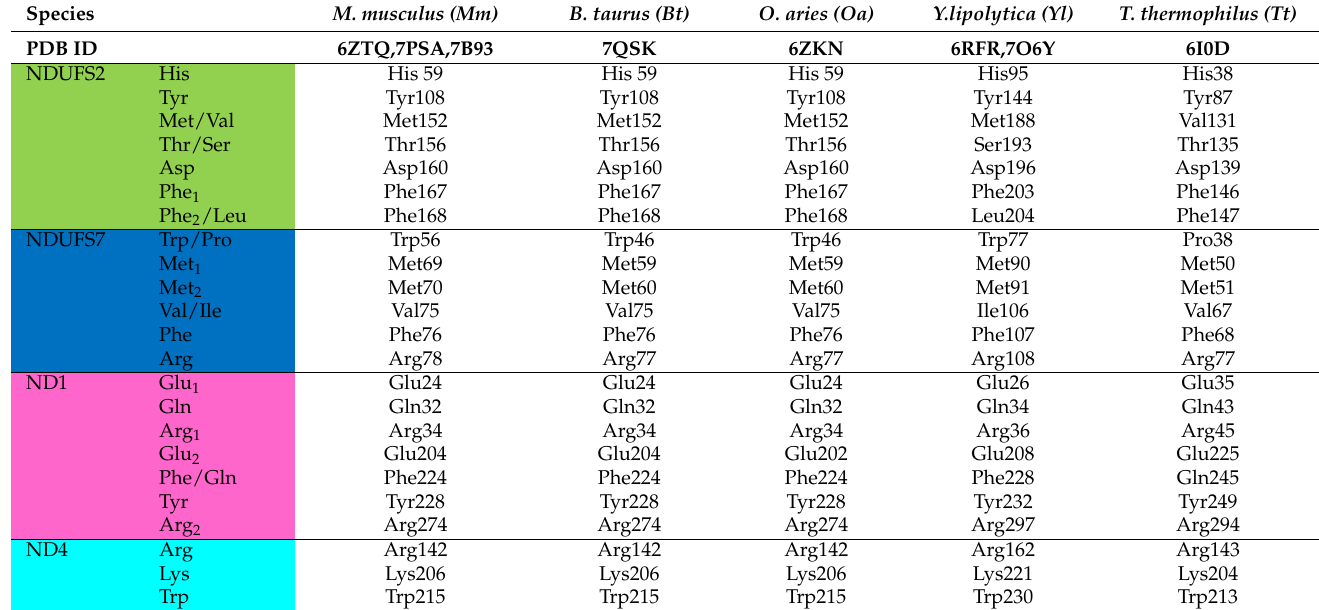
Table 1. Details of structures and residues shown in Figures 2 and